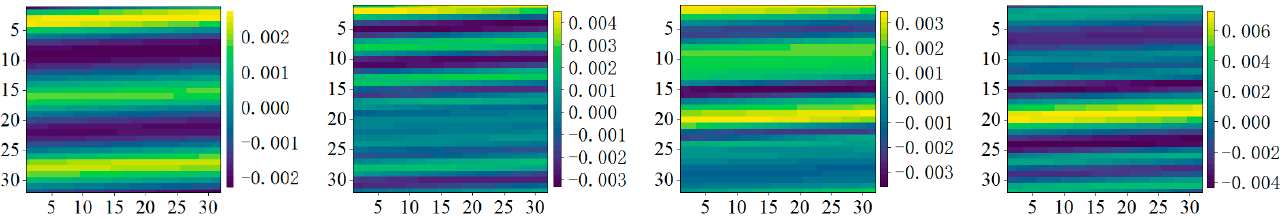
Figure 7. Data visualization of different fault types in the same channel.